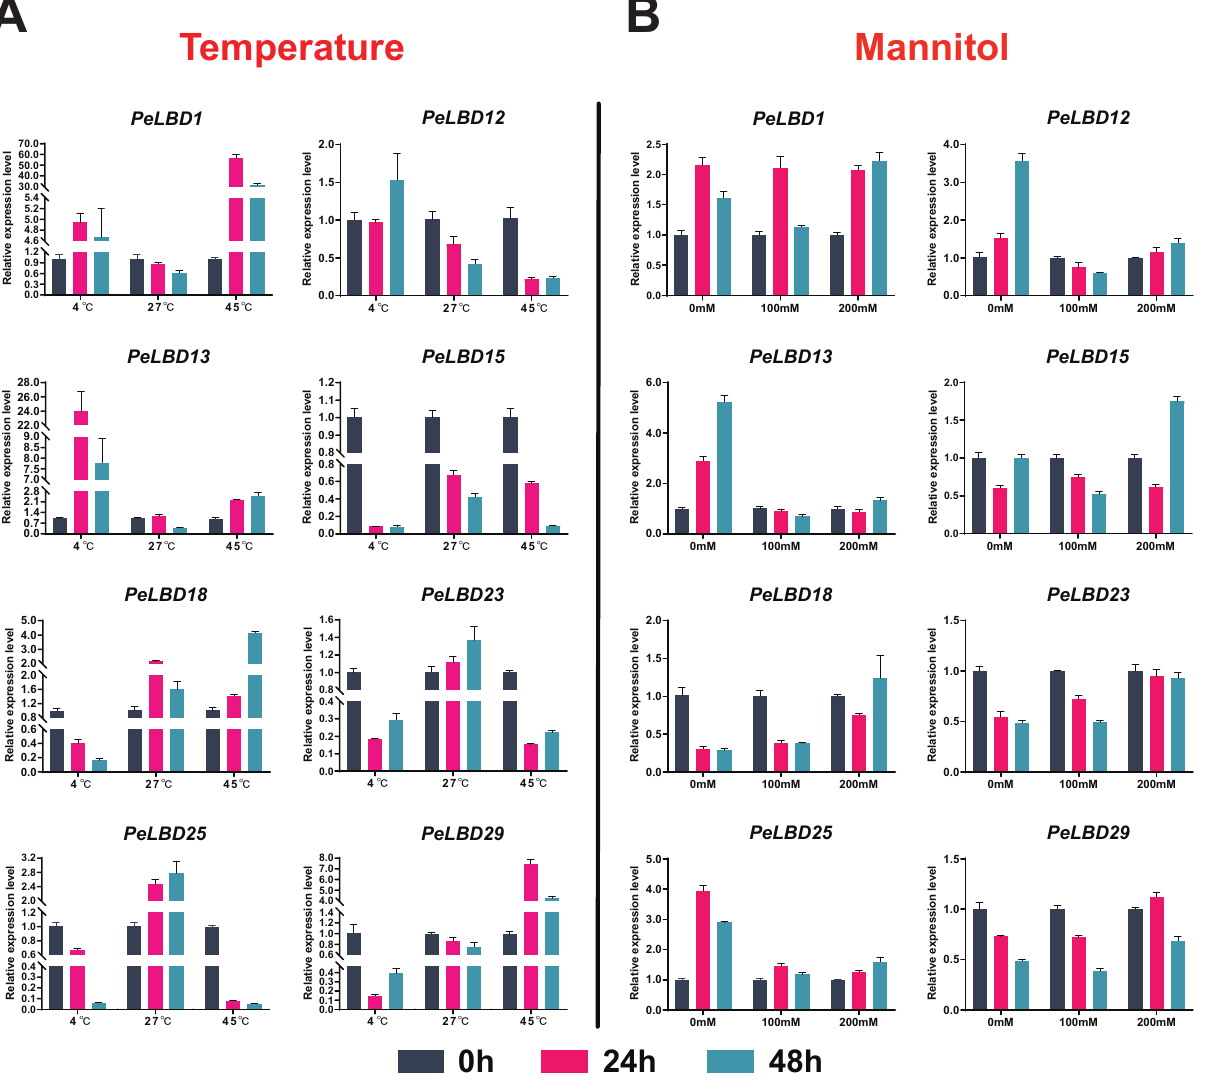
Figure 10. qRT-PCR analysis of eight genes ( PeLBD1 , PeLBD12 , PeLBD13 , PeLBD15 , PeLBD18 , PeLBD23 , PeLBD25 and PeLBD29 ) under ( A ) cold (4 ◦ C), heat (45 ◦ C) and ( B ) drought stress treatment. All experiments were performed independently at least three times. Error bars represent the standard deviation of three